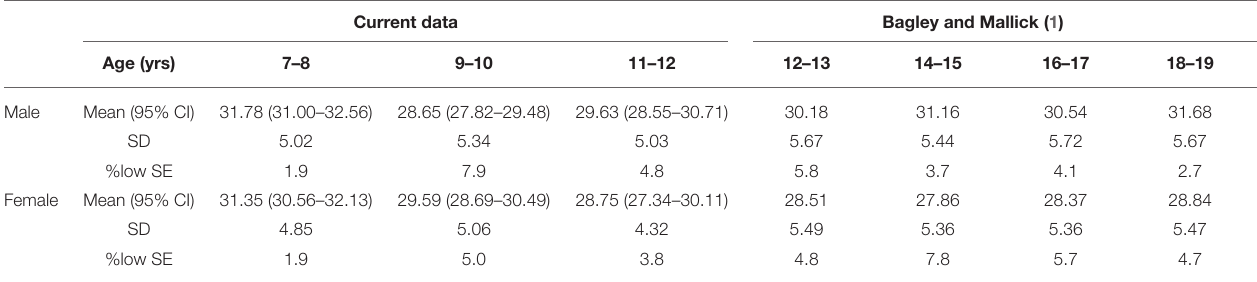
TABLE 2 | Normative data in males and females.